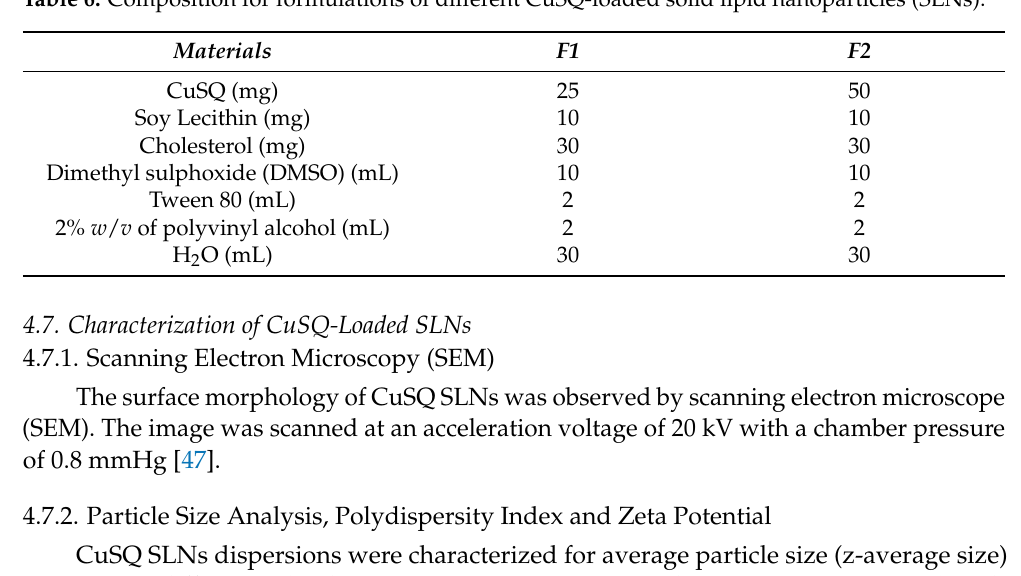
Table 6. Composition for formulations of different CuSQ-loaded solid lipid nanoparticles